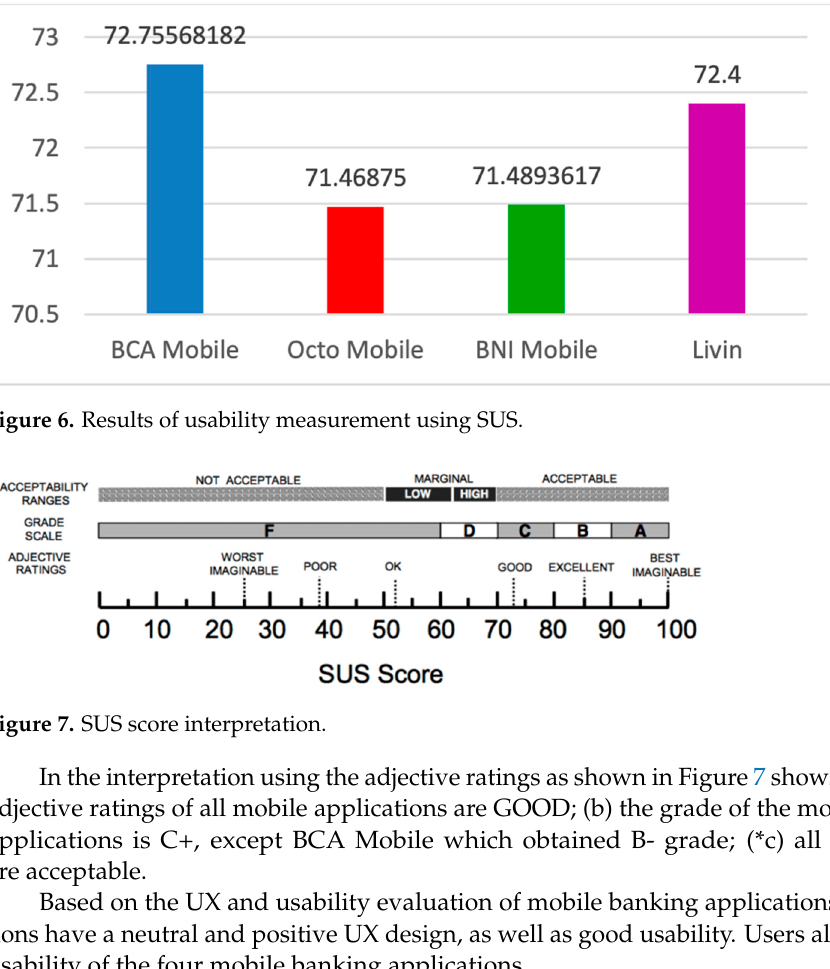
Figure 7. SUS score interpretation.